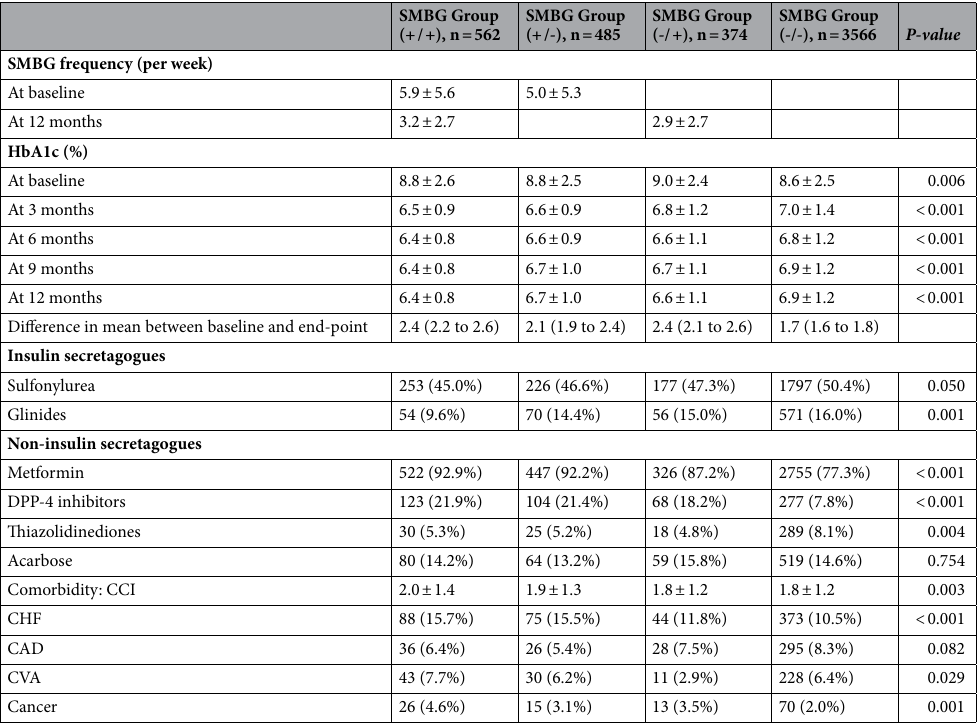
Table 2. Mean HbA1c levels during the observation period, anti-diabetic medications, and main comorbidities in each SMBG group. Results are expressed as mean ± SD, difference in mean (95% CI), or n (%). SMBG, self-monitoring of blood glucose; SD, standard deviation; CI, confidence interval; HbA1c, hemoglobin A1c; DM, diabetes mellitus; DPP-4, dipeptidyl deptidase 4; CHF, congestive heart failure; CAD, coronary artery disease; CVA, cerebrovascular accident.